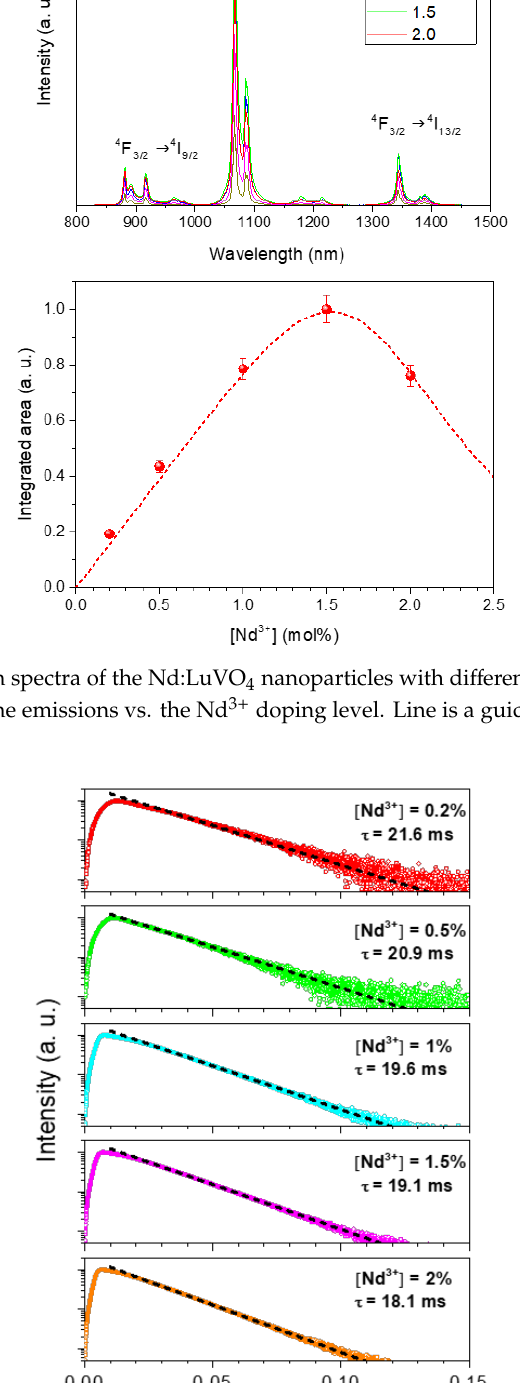
Figure 6. Concentration dependence of the experimental decay times. Dashed line represents the least squares fitting to Equation (1). Error bars have been included. 3.3. X-Ray Attenuation The X-ray attenuation properties of the optimum nanophosphor (Nd (1.5%):LuVO 4 ) and those of Iohexol, which is one of the most commonly used CT contrast agents in clinics, were measured in aqueous suspensions. The obtained X-ray attenuation phantom images are shown in Figure 7 (top), where it can be clearly observed that the contrast produced by increasing the nanophosphor ’s concentration in the suspensions is higher than that corresponding to Iohexol, suggesting better performance of our